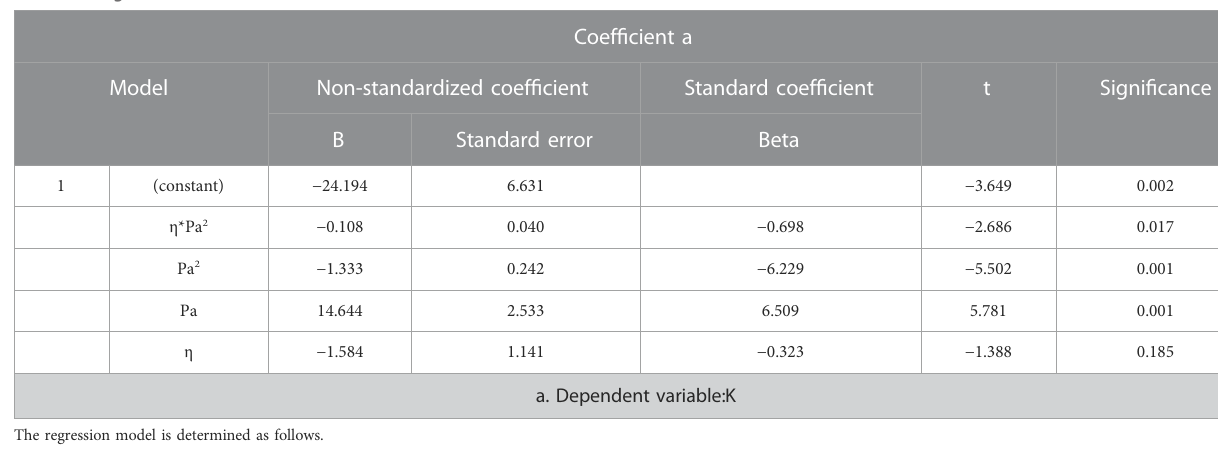
TABLE 10 Regression coef fi cients.